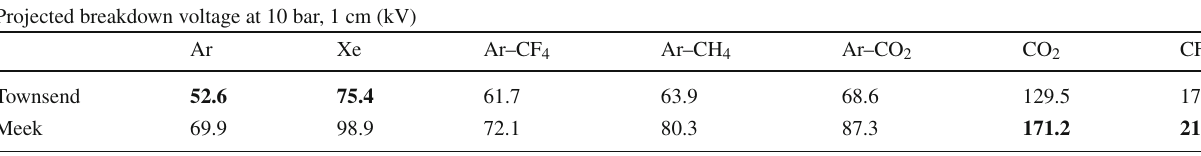
Fig. 5 Breakdown data for various gases and gas mixtures plotted alongside the PyBoltz Predictions for each gas. *5 mm Xe data presented from a functionally equivalent device in Ref. [19] Table 2 Projected breakdown voltage of several gases at a benchmark point of 10 bar pressure, 1 cm gap distance. Based on the observed trends the bold values are the recommended projections for the pure